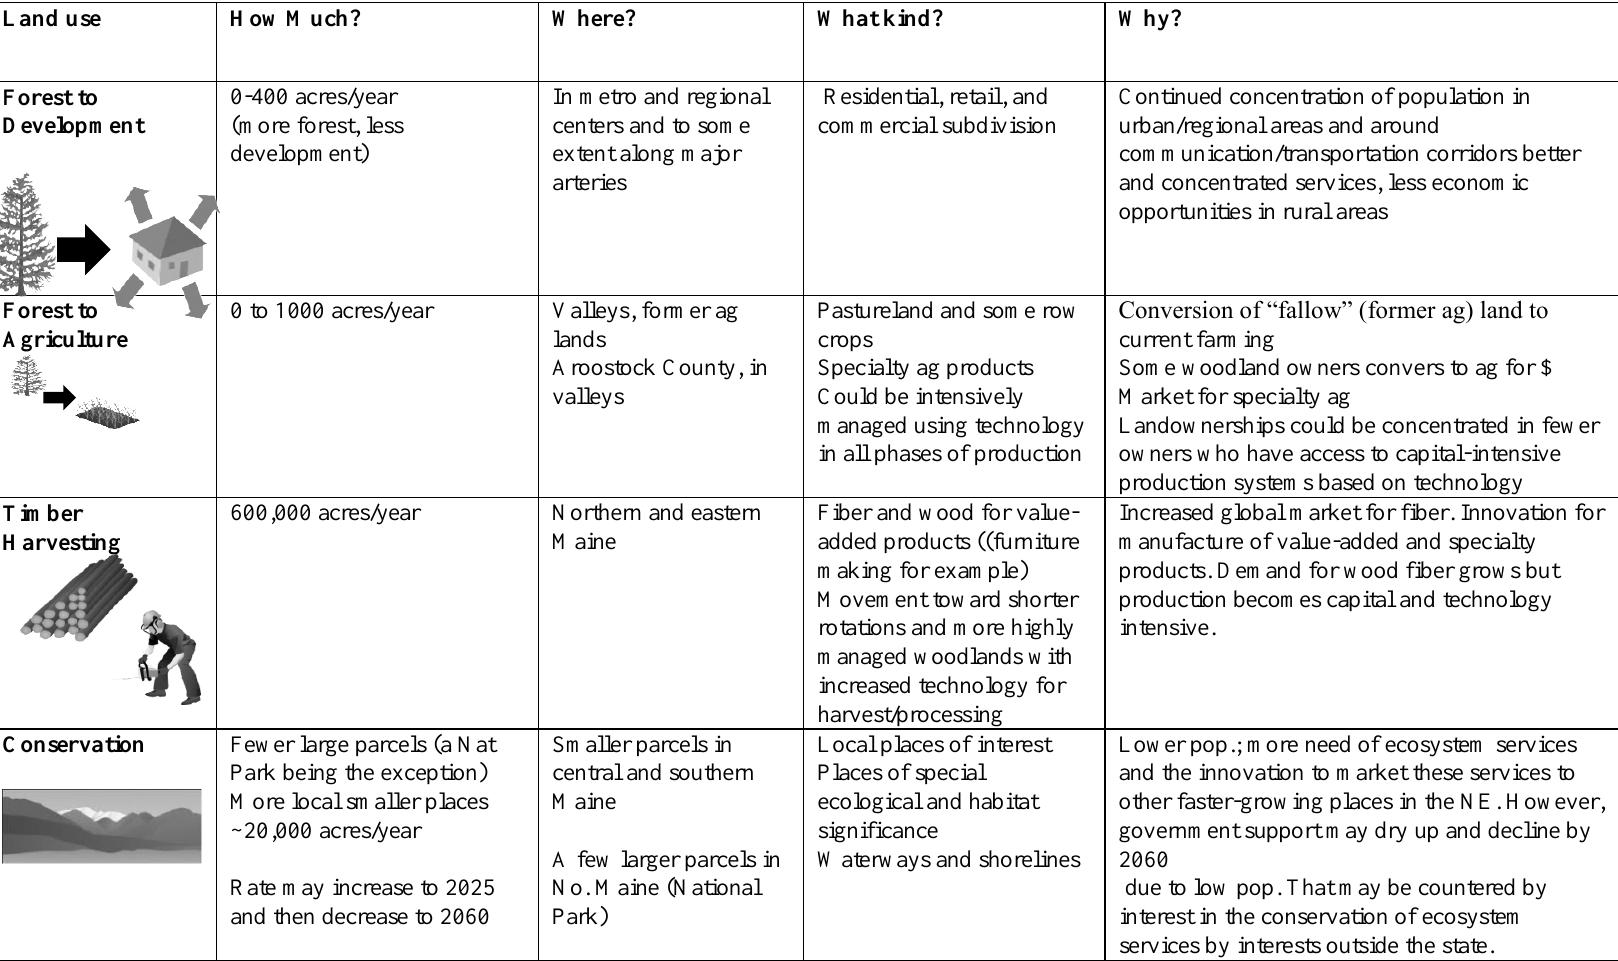
Table A2.12. Scenario 4: Green